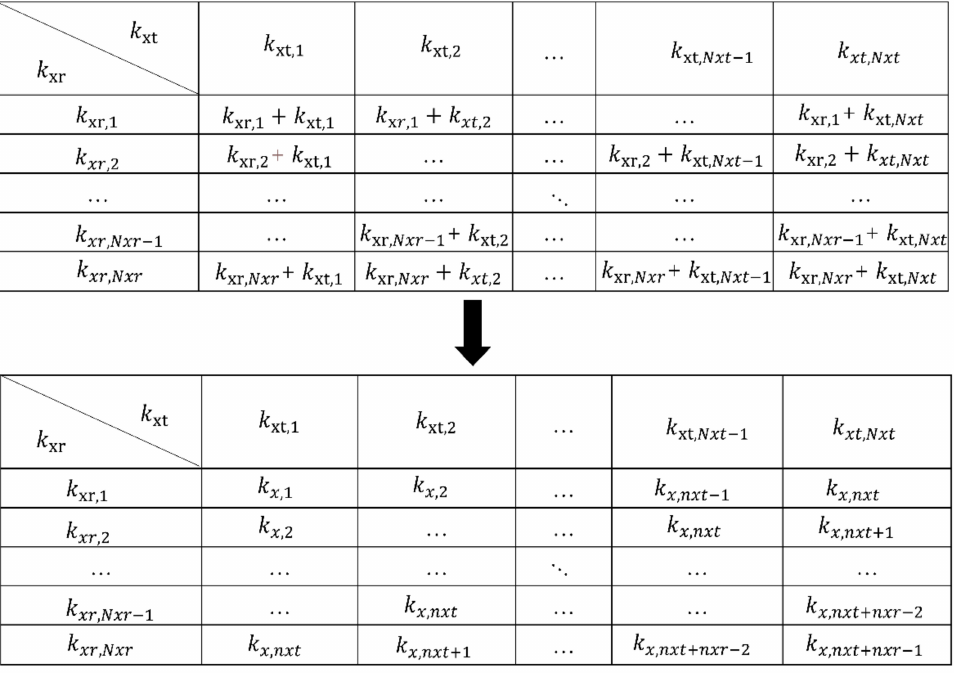
Figure 2. The spatial wavenumber rearrangement